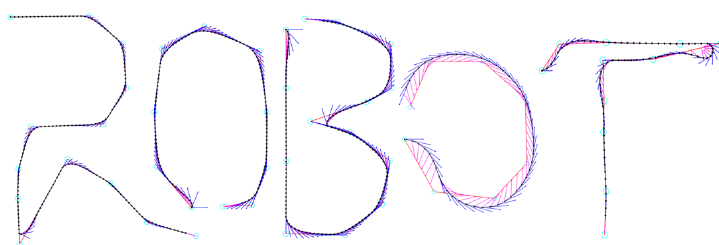
Figure 11. Path smoothing of differently shaped polyline paths.